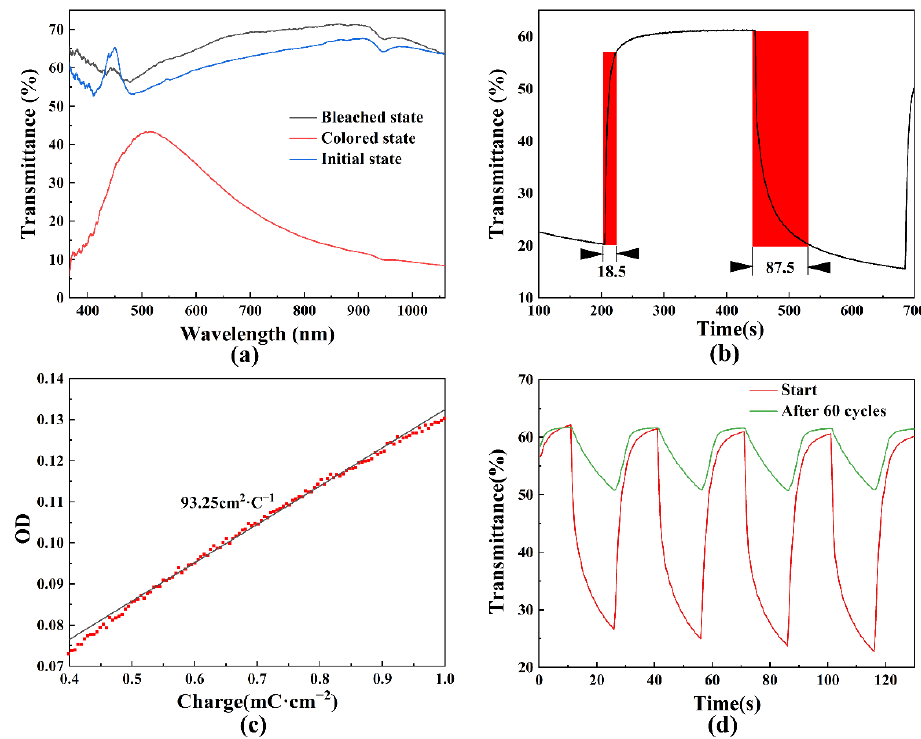
Figure 9. Properties of the annealed film using 3.8 wt.% PVA ink formulas: ( a ) optical transmittance spectra in initial, bleached and colored state, ( b ) response time, ( c ) optical density, ( d ) transmittance at the start and after 60 cycles (at 600 nm wavelength).